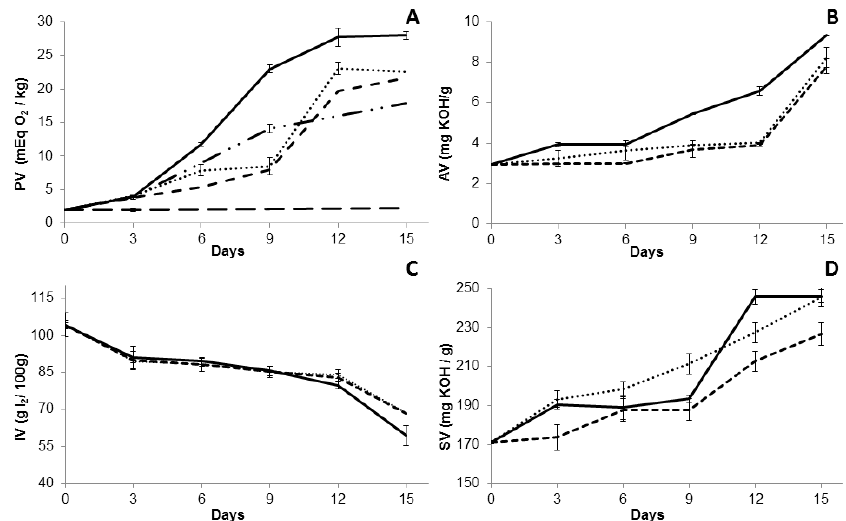
Figure 2. Physicochemical properties of bullfrog oil from the Schaal oven test conducted over 15 days at 60 °C. ( A ) Peroxide value; ( B ) Acid value; ( C ) Iodine value; ( D ) Saponification value. Samples: BO ( ― ); BOAm (····); BOAmx ( — ··); BOTm (----); BOTmx ( – – ).